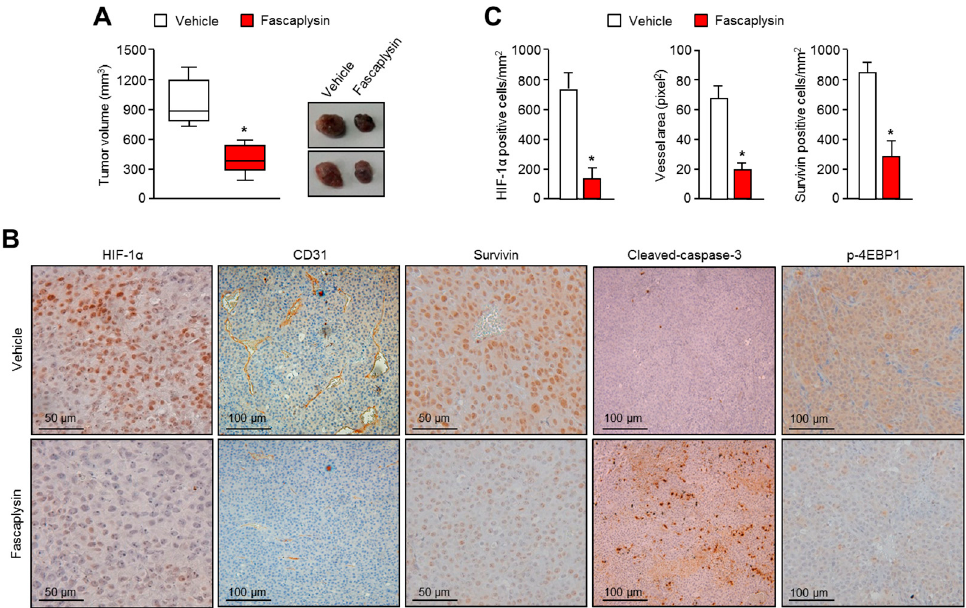
Figure 4. Effects of fascaplysin on angiogenesis and apoptosis in the xenografted tumor models. ( A ) Three weeks after injection, mice were injected daily with fascaplysin or dimethyl sulfoxide (DMSO) and then the tumor volumes were measured. In the box plots, the final tumor volumes are shown ( n = 6). The whiskers in the box plots represent the maximum and the minimum value; * p < 0.05; ( B ) Tumors were fixed and embedded into paraffin blocks and then cut into 6 µ m sections. Tumor tissues were immunostained with the indicated antibodies. Immunostained slides were visualized with the avidin-biotin-horseradish peroxidase method using diaminobenzidine as the chromogen; ( C ) Three sections of each tumor (five fields per section) were reviewed for histologic assessments. HIF-1 α and survivin protein levels were determined by counting of immunopositive cells. The area of each CD31-positive vessel was determined in units of pixel2 using the Image J software. Vascular area per mm 2 was calculated by dividing the sum of the vascular areas by the total tissue area; * p < 0.05.